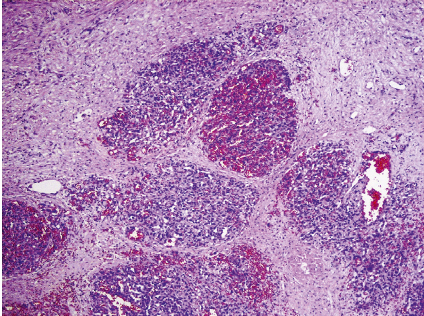
Figure 3: Microscopic view of angiosarcoma with hemorrhagic areas and vascular channels lined by endothelial atypical cells (hematoxylin and eosin staining,